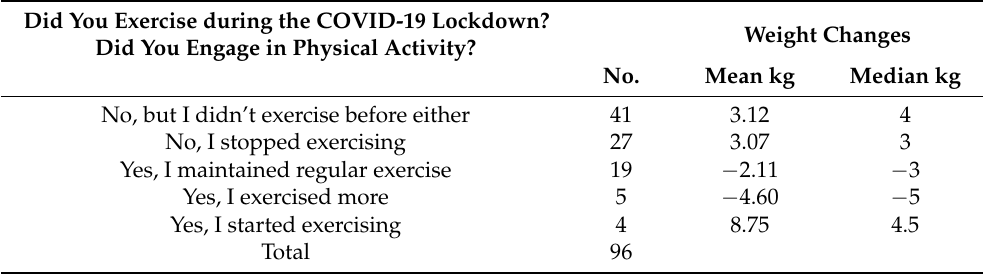
Table 9. Mean and median values of weight changes in relation to self-reported physical activity levels during the